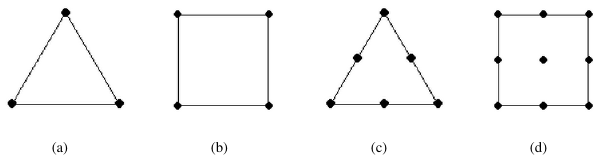
Figure 1. 2-D finite elements evaluated in the manufactured solu- tion test cases. (a) Tri 3, (b) Quad 4, (c) Tri 6, (d) Quad